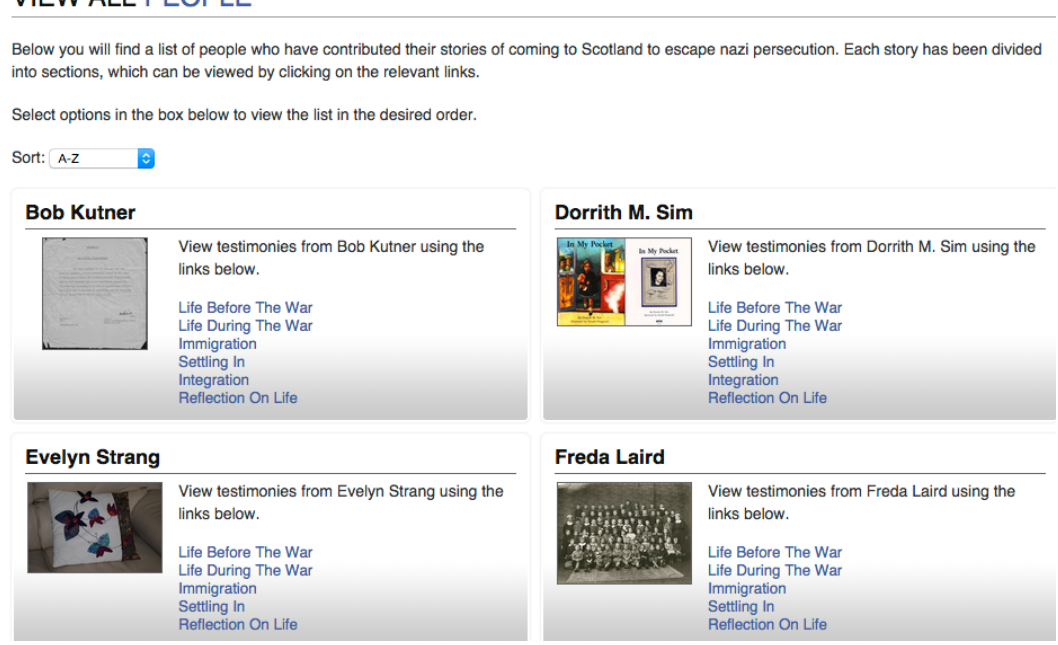
Figure 3. Examples of Front page for testimonies .